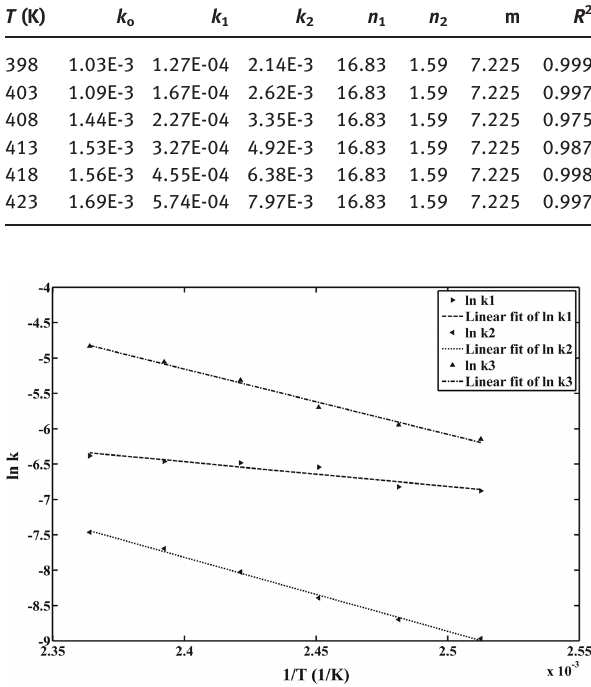
Figure 8: Arrhenius plot of the rate constants.